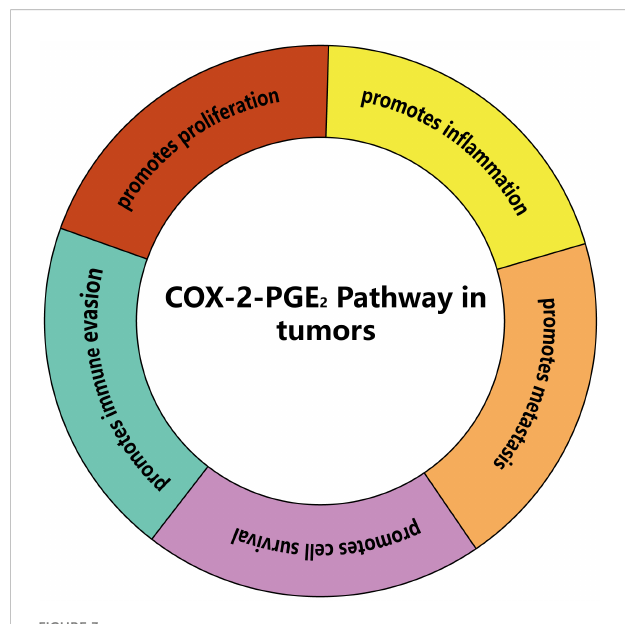
FIGURE 3 The main effects of COX-2-PGE2 pathway on tumors. COX-2-PGE2 pathway can promote proliferation, in fl ammation, metastasis, cell survival and immune evasion of tumors.